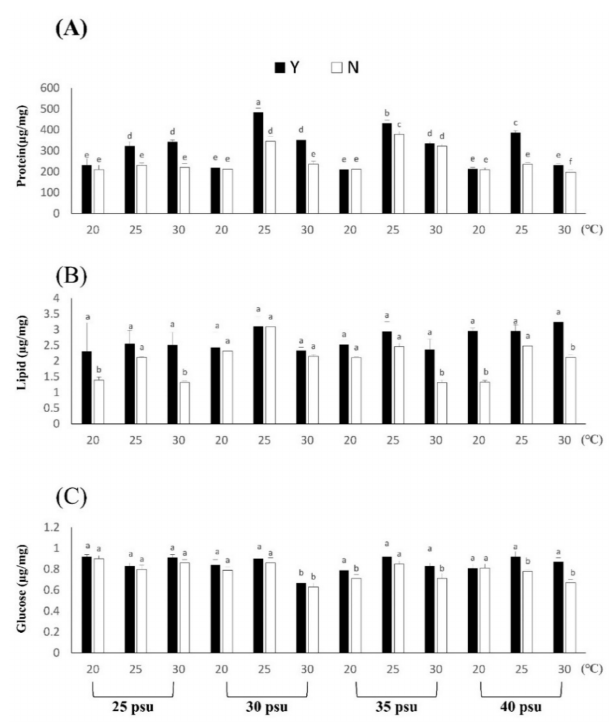
Figure 3. The effect of feeding on Briareum violacea body composition during temperature and salinity stress. Different Latin alphabet letters indicate significant differences among groups ( p < 0.05). The values are expressed as the means ± SDs ( n = 30 colonies). ( A ): protein, ( B ): lipid, ( C ):